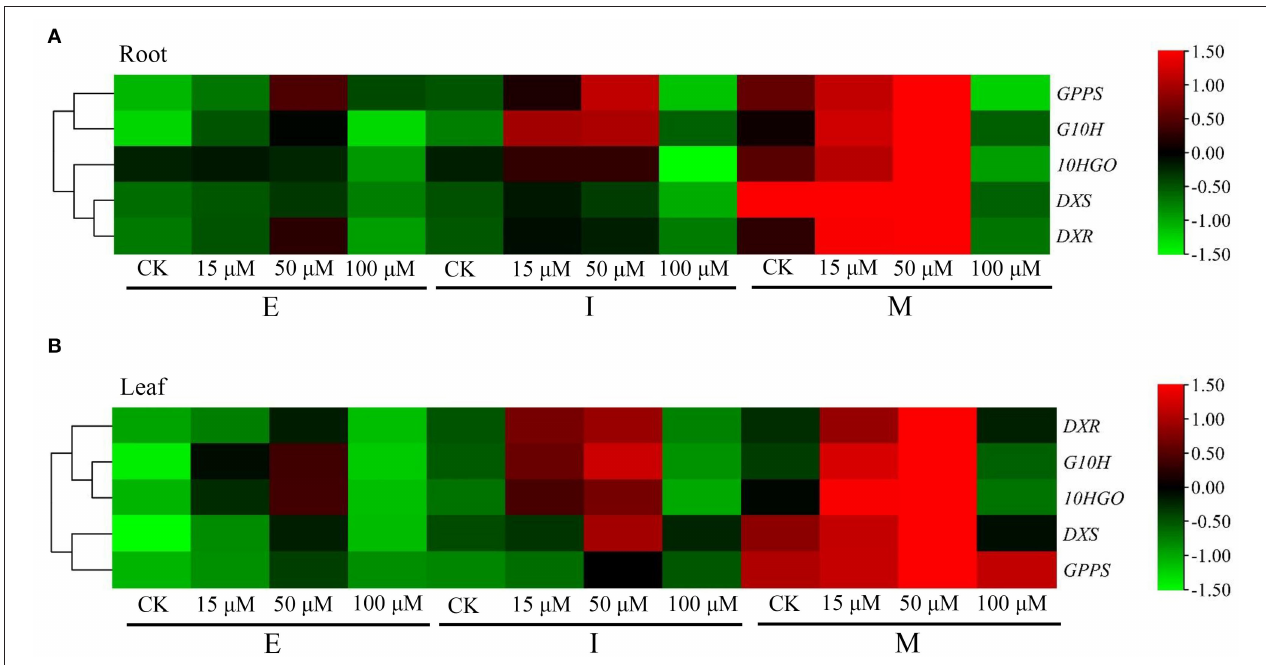
FIGURE 5 | Expression pattern of iridoid glycoside synthetase genes in R. glutinosa treated with 5-azaC. (A,B) respectively, represent the relative expression level of DXS , DXR , GPPS , G10H, and 10HGO in Jinjiu root and Jinjiu leaf of R. glutinosa treated with 5-azaC,